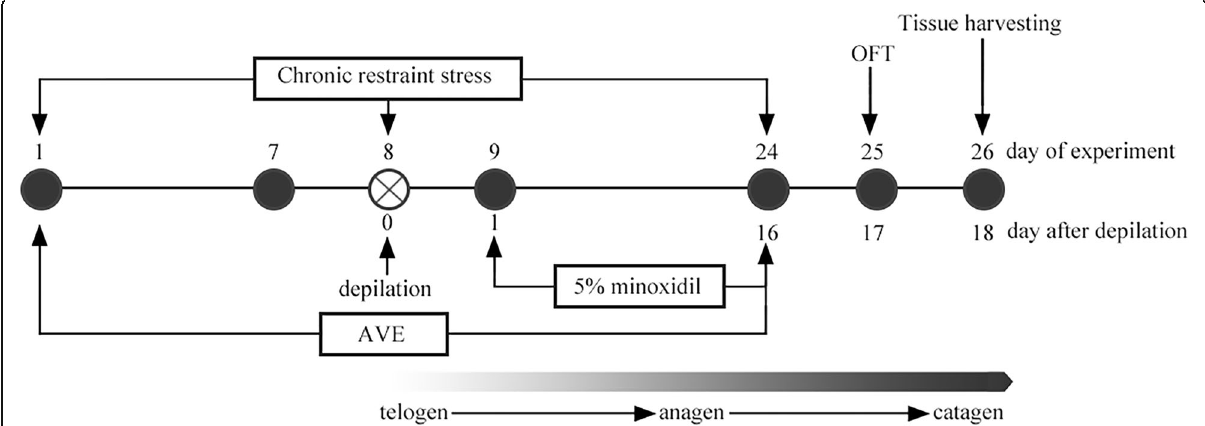
Fig. 1 Time schedule of the experiment. Chronic restraint stress and AVE administration were applied on day 1 and lasted for 23 days. 5% minoxidil was applied on day 9 of the experiment (day 1 after depilation) and lasted for 16 days. The depilation of all mice was on day 8 of the experiment to induce anagen (The day on depilation did not apply restraint stress or drug). Behavioral test (OFT) was exmained on day 25 and tissue harvesting was collected on day 26 of the